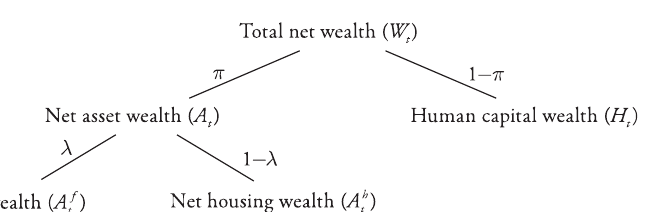
Figure!: Decomposition of Total